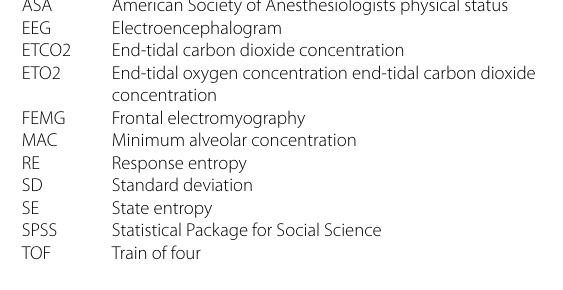
Table 3 SE and RE at different MAC and TOF of atracurium group TOF_50%_mac_0.8%